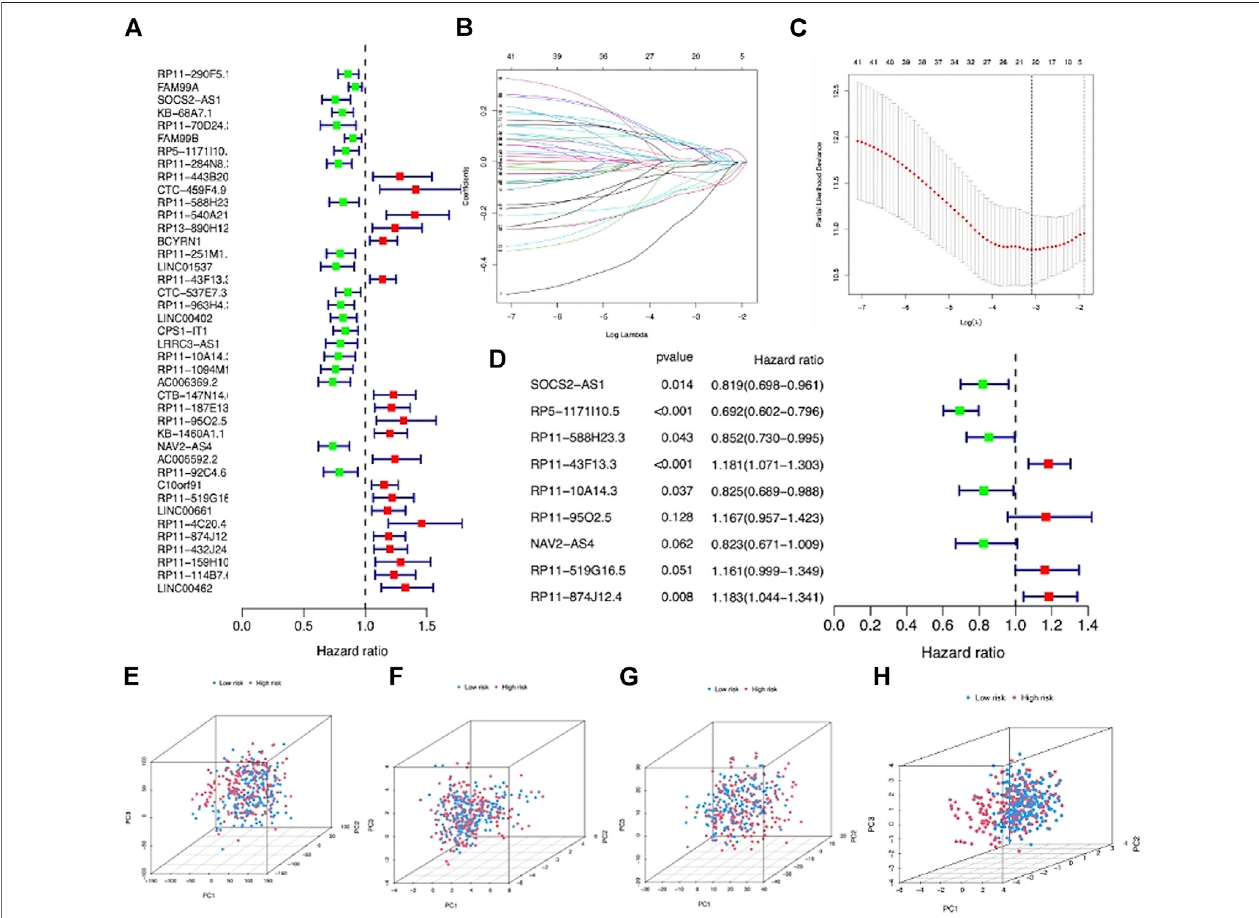
FIGURE3| Construction ofam7G-related lncRNA riskmodel forLIHCpatients. (A) Forest plotshowed 41prognosticlncRNAsscreened via univariate regression analysis. (B) LASSO regression of 20 m7G-related lncRNAs. (C) Cross-validation in LASSO regression. (D) Forest plot displayed 9 m7G-related lncRNAs selected by multivariate regression analysis. (E) PCA based on entire LIHC gene expression pro fi les in the two groups. (F) PCA based on 22 m7G regulator gene expressions in the two groups. (G) PCA based on 992 m7G-related lncRNA expressions in the two groups. (H) PCA based on 9 prognostic m7G-related lncRNA expressions in the two